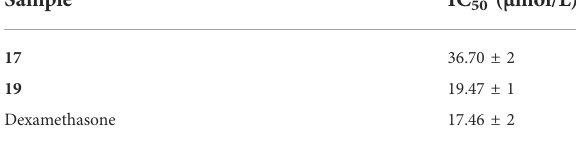
TABLE 3 DPPH free-radical-scavenging of compounds 1-19 a .